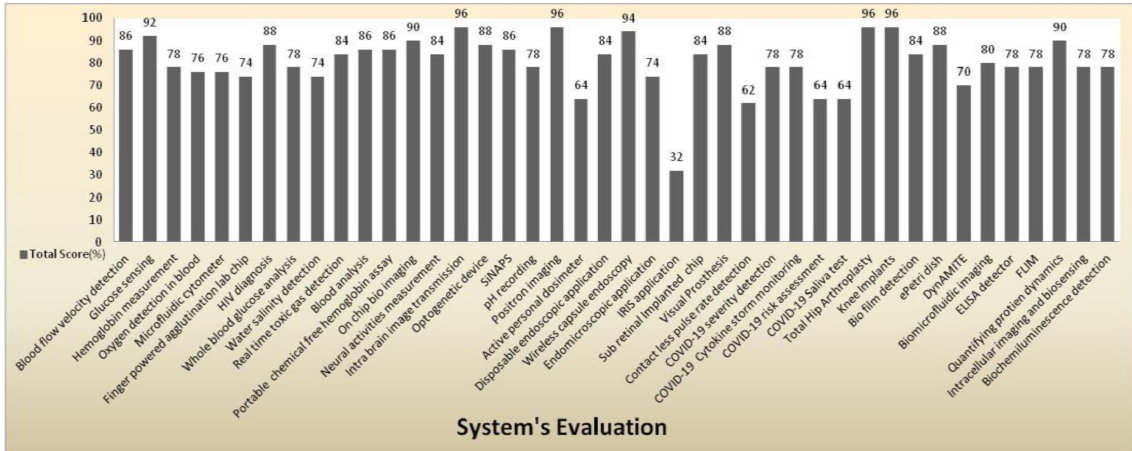
Figure 47. System evaluation represents the total score of every medical